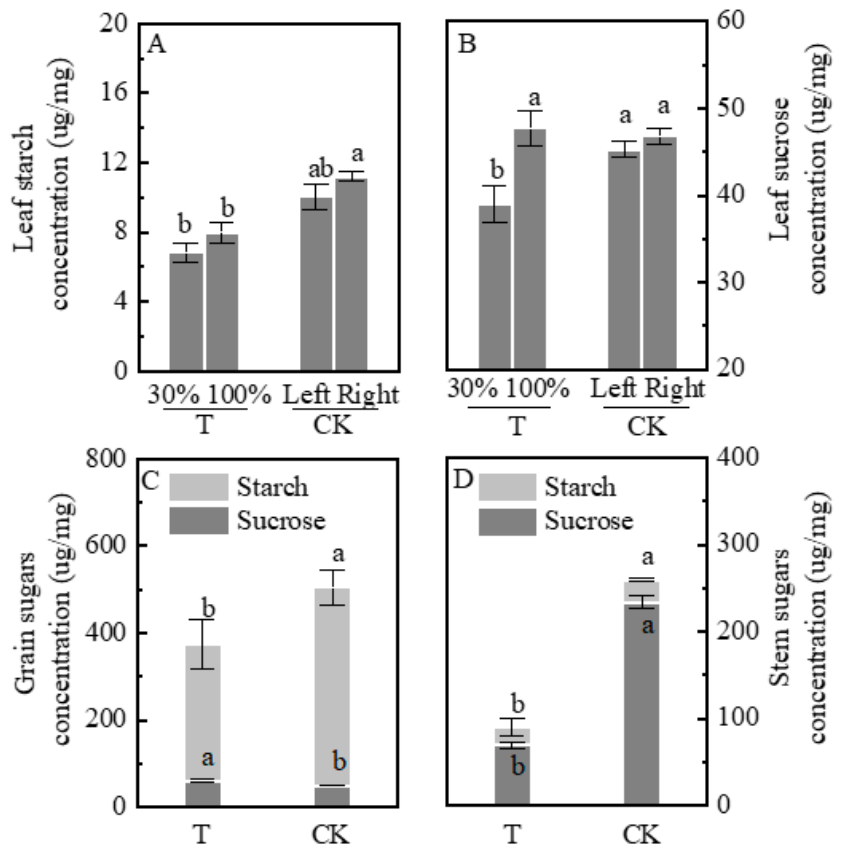
Figure 4. Starch and sucrose concentrations in organs in shading treatments. ( A ): leaf starch concentration; ( B ): leaf sucrose concentration; ( C ): grain starch and sucrose concentration; ( D ): stem starch and sucrose concentration. Plants grown under heterogeneous light (T), the left side leaves were under shade (T-30%) and right side leaf under natural light (T-100%). All leaves were under full sunlight (CK). Data are averages of three replicates and bars represent standard errors. Data with different letters are significantly different ( p <